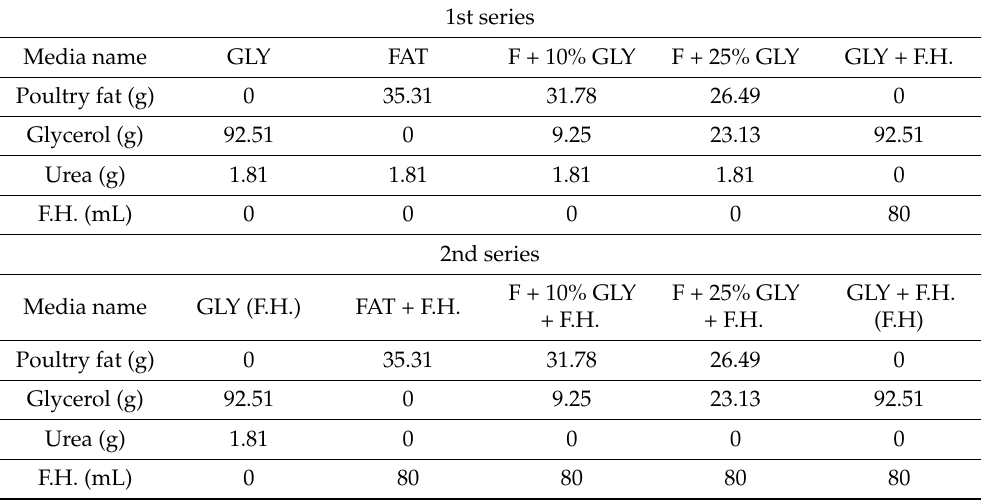
Table 3. Composition of production media at C/N ratio of 50 for volume of 1000 mL of